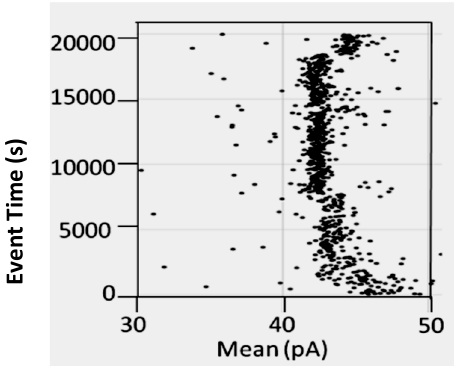
Figure 12. Part of the time-trace is shown for Bt-8gc events observed in an experiment that ran for two days. For T = 0 s to T = 3000 s the device is not at standard temperature and other conditions. At T = 3000 to 7500 s the channel operates in its normal, exposed chamber, evaporative mode, which leads to a concentration in the cis -chamber, including a concentration of salt (from 1.0 M KCl). At T = 3000 s, the standard detector is established, aside from having its operational pH set at 9.0 instead of 8.0. At T = 7500 s the channel changes configuration, and the hairpin signals obtained are now notably different in just the one attribute (mean). A brief return to a normal channel conductance occurs around T = 14,000 s, with a return to gated configuration at T = 14,500 s. A final return to normal channel conductance occurs around T = 18,000 s.